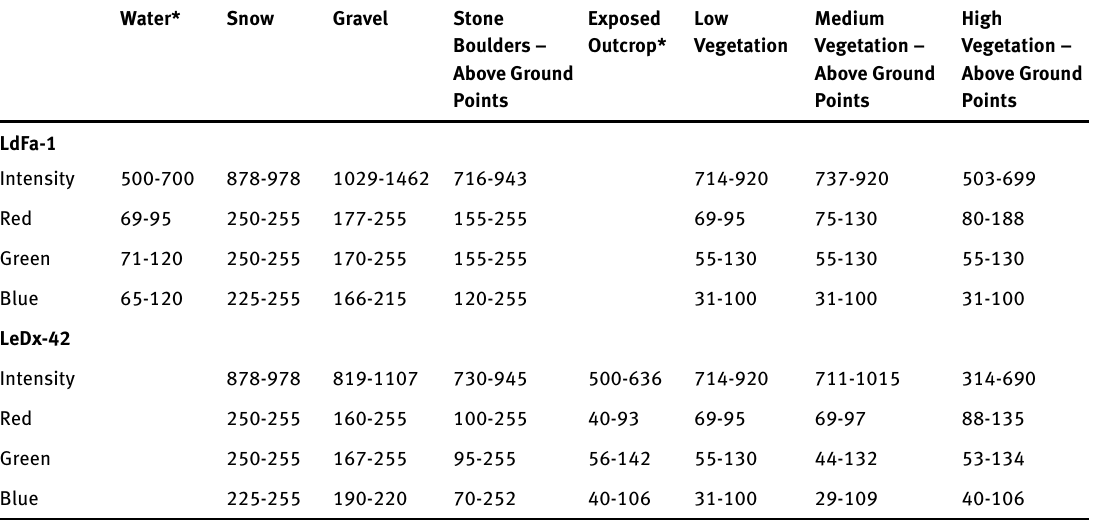
Table 1: Parameters and ranges used to fingerprint and define each surface material from LdFa-1 and LeDx-42. A combination of the four parameters can identify and isolate each material from the original point